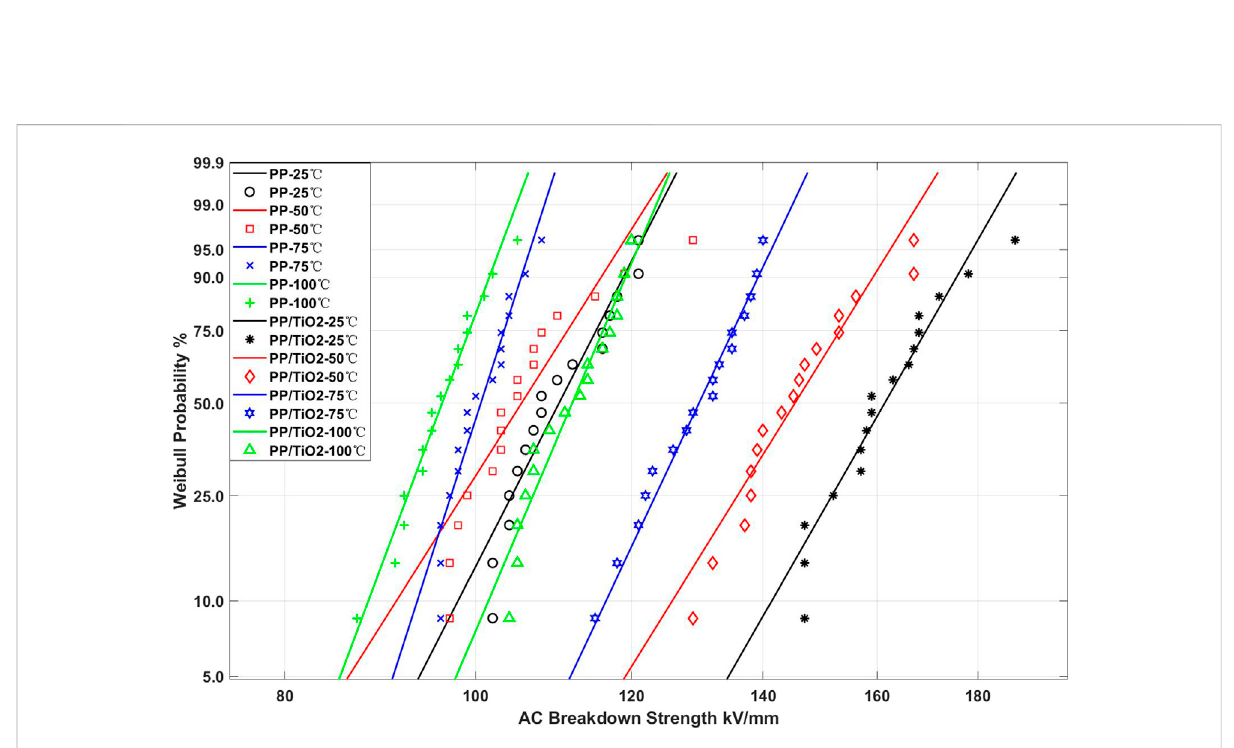
FIGURE 8 Weibull plots of AC breakdown strength at different